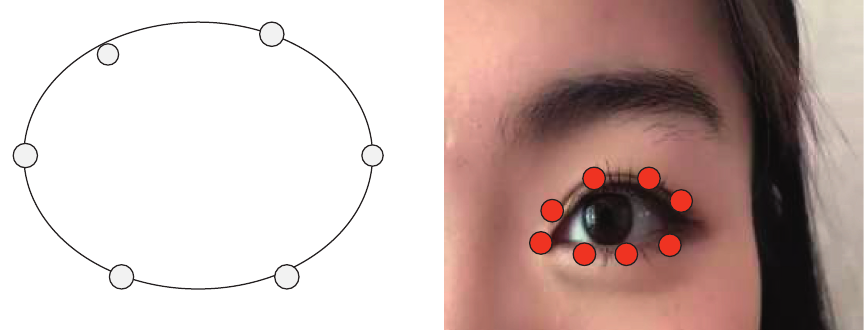
Figure 6: Eye feature point model and schematic diagram of eye feature point detection.